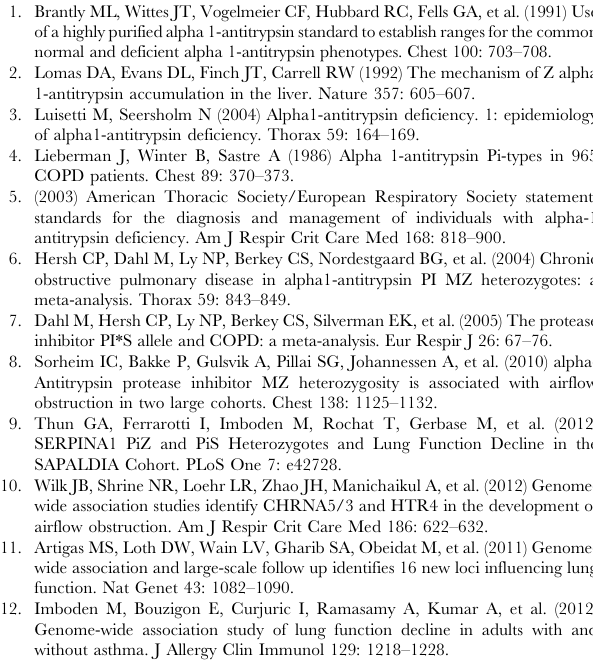
Table S2 Characteristics of study populations contributing to the SNP association analyses with FEV1. Table S3 The top 100 ranking SNPs associated with AAT serum level in SAPALDIA (N= 1392). Table S4 SERPINA regional variants based on 1000 Genomes imputation reaching statistical significance for the association with AAT serum level in SAPALDIA (N =1392). Table S5 The top 100 ranking SNPs associated with AAT serum level, conditional on PI S and Z alleles in SAPALDIA (N = 1392). Table S6 Accuracy of 1000 Genomes based imputation in the SERPINA1 region in SAPALDIA (N =1392). Table S7 Further variants in the SERPINA1 coding region, present in a SAPALDIA subsample with abnormally low AAT serum levels (N =410). Table S8 Descriptions and acknowledgments of individual studies contributing to the SNP association analyses with FEV1.